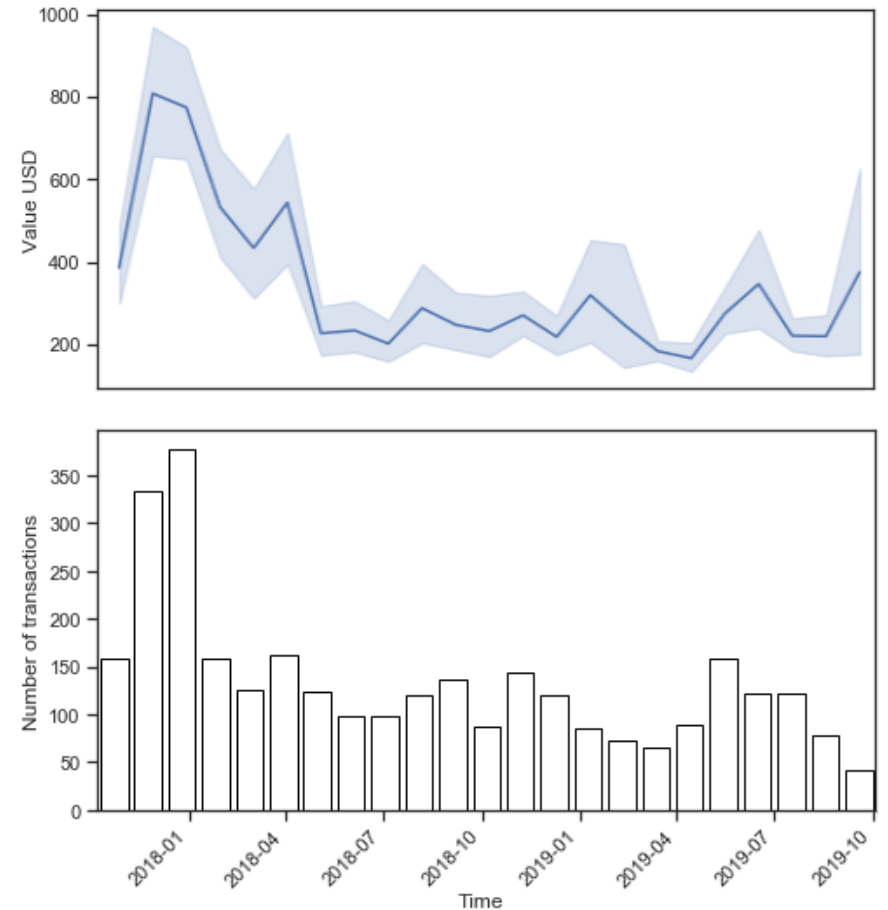
Figure 6. Sum of USD values ( top ) and number of transactions ( bottom ) for 30-day periods for one of the Ethereum